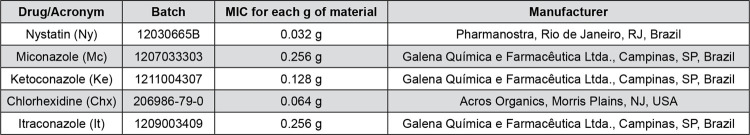
Antifungal agents and the previously determined minimum inhibitory concentrations for the biofilm of
C. albicans